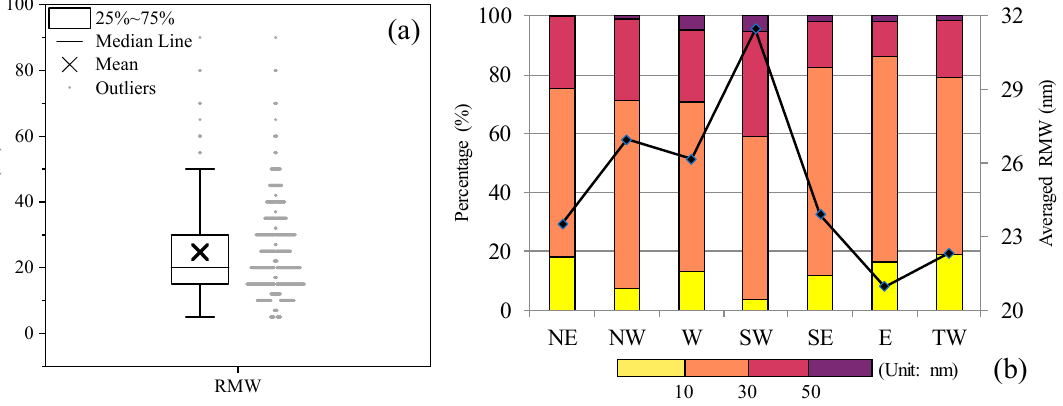
Figure 6. ( a ) Box plot of RMW (unit: nm). The samples are showed with gray dots on the right of the box. ( b ) Percentages of samples with different RMW (bars; yellow: RMW ≤ 10 nm; orange: 10 nm < RMW ≤ 30 nm; red: 30 nm < RMW ≤ 50 nm; purple: RMW > 50 nm) and the average RMW (right axis, black line, unit: nm) in the subregions during 2001–2021.